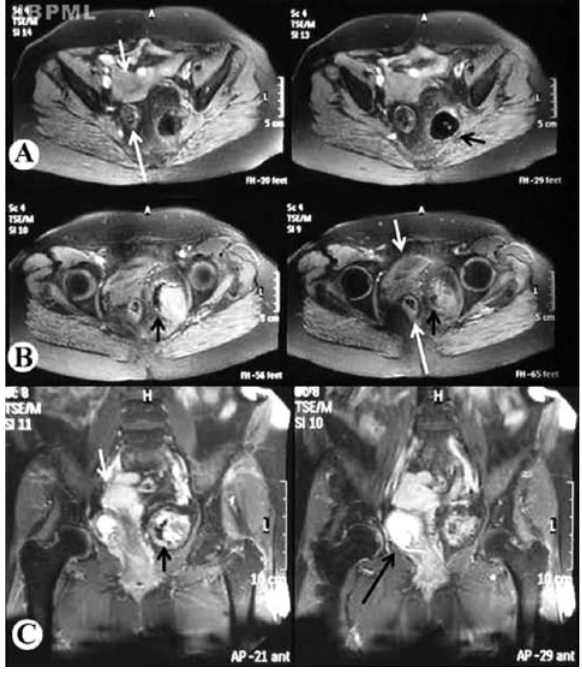
Figure 2 – Magnetic resonance imaging. (A) Fat-suppressed T1-weighted axial images: superior sections show the posterior tumoral lobe with a densely calcified appearance (black arrow). (B) Fat-suppressed T1-weighted axial images: inferior sections show the anterior tumoral lobe with lower density. The black arrow indicates the dense calcification observed only in the periphery. In both A and B figures the short white arrows indicate the uterus and the long white arrows indicate the rectum. Note that the posterior tumoral lobe in “A” has a density even higher than the femur heads in “B”. (C) Gadolinium-enhanced fat-suppressed T1-weighted coronal images: the short black arrow indicates again the densely calcified periphery of the anterior tumoral lobe. The short white arrow indicates the uterus and the long black arrow indicates the bladder, highlighted by the